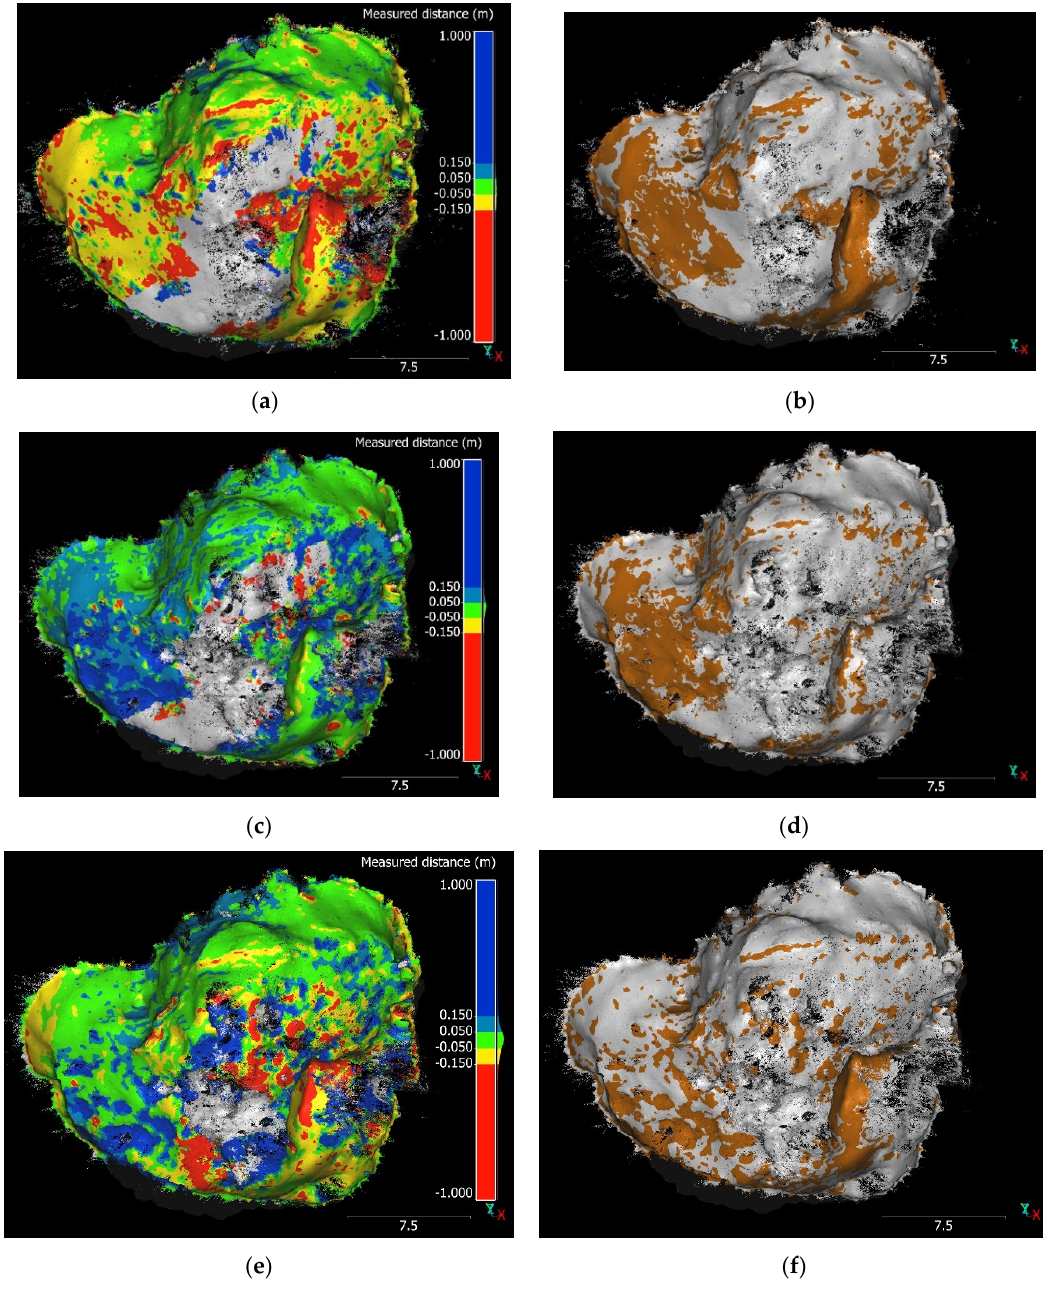
Figure 4. Measured distances and regions of detectable change for comparisons Terr 2017/18, 2018/19, and 2017/19 (see Table 4): ( a ) Terr 2017/18 measured distance (m), Terr 2017/18: measured distances of terrestrial 2017 to terrestrial 2018. ( b ) Terr 2017/18 detectable change, Terr 2017/18: de- tectable change of terrestrial 2017 to terrestrial 2018. ( c ) Terr 2018/19 measured distance (m), Terr 2018/19: M3C2 distances of terrestrial 2018 to terrestrial 2019. ( d ) Terr 2018/19 detectable change, Terr 2018/19: detectable change of terrestrial 2018 to terrestrial 2019. ( e ) Terr 2017/19 measured dis- tance (m), Terr 2017/19: measured distances of terrestrial 2017 to terrestrial 2019. ( f ) Terr 2017/19 detectable change, Terr 2017/19: detectable change of terrestrial 2017 to terrestrial 2019. Note the different information portrayed by the color gray: in ( a , c , e ), gray areas show areas where no change was measured (due to missing points or the maximum depth of 1 m was exceeded); in ( b , d , f ), the gray color shows points with no detectable change. The change detection over time using the point clouds from the aerial (UAV) imagery resulted in partly similar patterns and mean measured distances compared to the changes found in the point clouds from the terrestrial imagery, with generally lower mean local levels of detection and larger areas of detectable change: The 2017/18 comparison shows detectable negative change at the earth pillar (but smaller areas with distances larger than − 15 mm) and at the upper part of the western slope ( − 15 mm to 5 mm), and shorter meas- ured distances in areas of detectable change in the northern wall (mainly ±5 mm and only small areas of − 15 mm to − 5 mm). The large areas of negative detectable change at the bottom of the western slope are missing. Only the positive blobs of the stalks at the tran- sition of the steep western slope to the flatter lower part are also visible at the same meas- ured distance in the comparison of the aerial point clouds of 2017/18. The mean measured distance for all points is − 27 mm ( − 39 mm for points with detectable change) at a mean local level of detection of 32 mm. A total of 52% of the 2018 aerial point cloud resulted in detectable change. From 2018 to 2019, the point clouds resulting from aerial imagery show